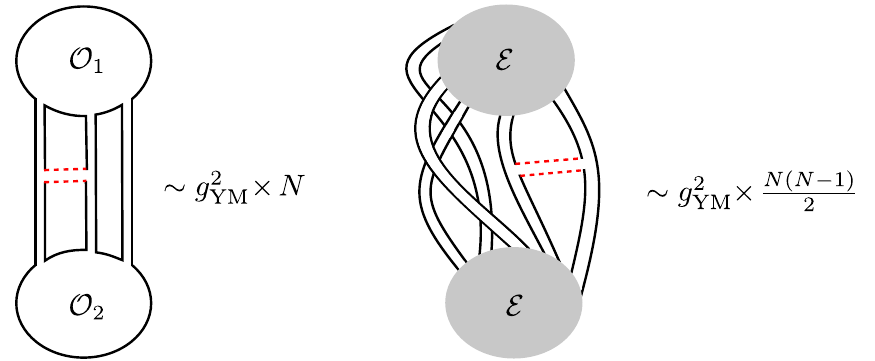
Figure 5 . The comparison of large N two-point functions of single-trace operators (left panel) and determinant operators (right panel). Unlike the single-trace two-point function, Wick contractions of determinant operators are complicated owing to the epsilon tensors. In addition, the one-loop corrections from the gluon exchange are enhanced by a combinatorial factor N ( N (cid:0) 1) =